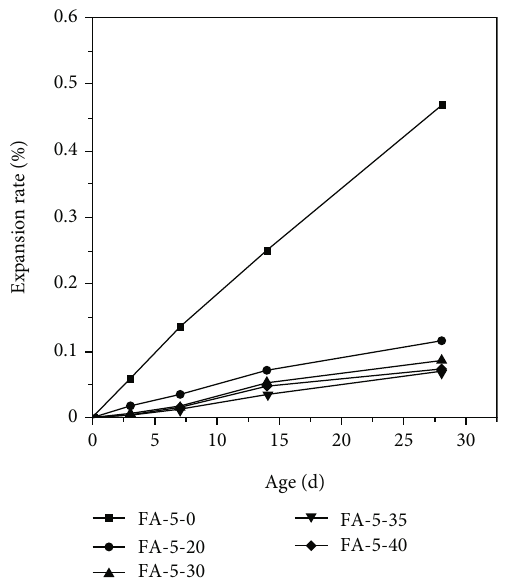
Figure 17: E ff ect of coal ash on alkali-aggregate